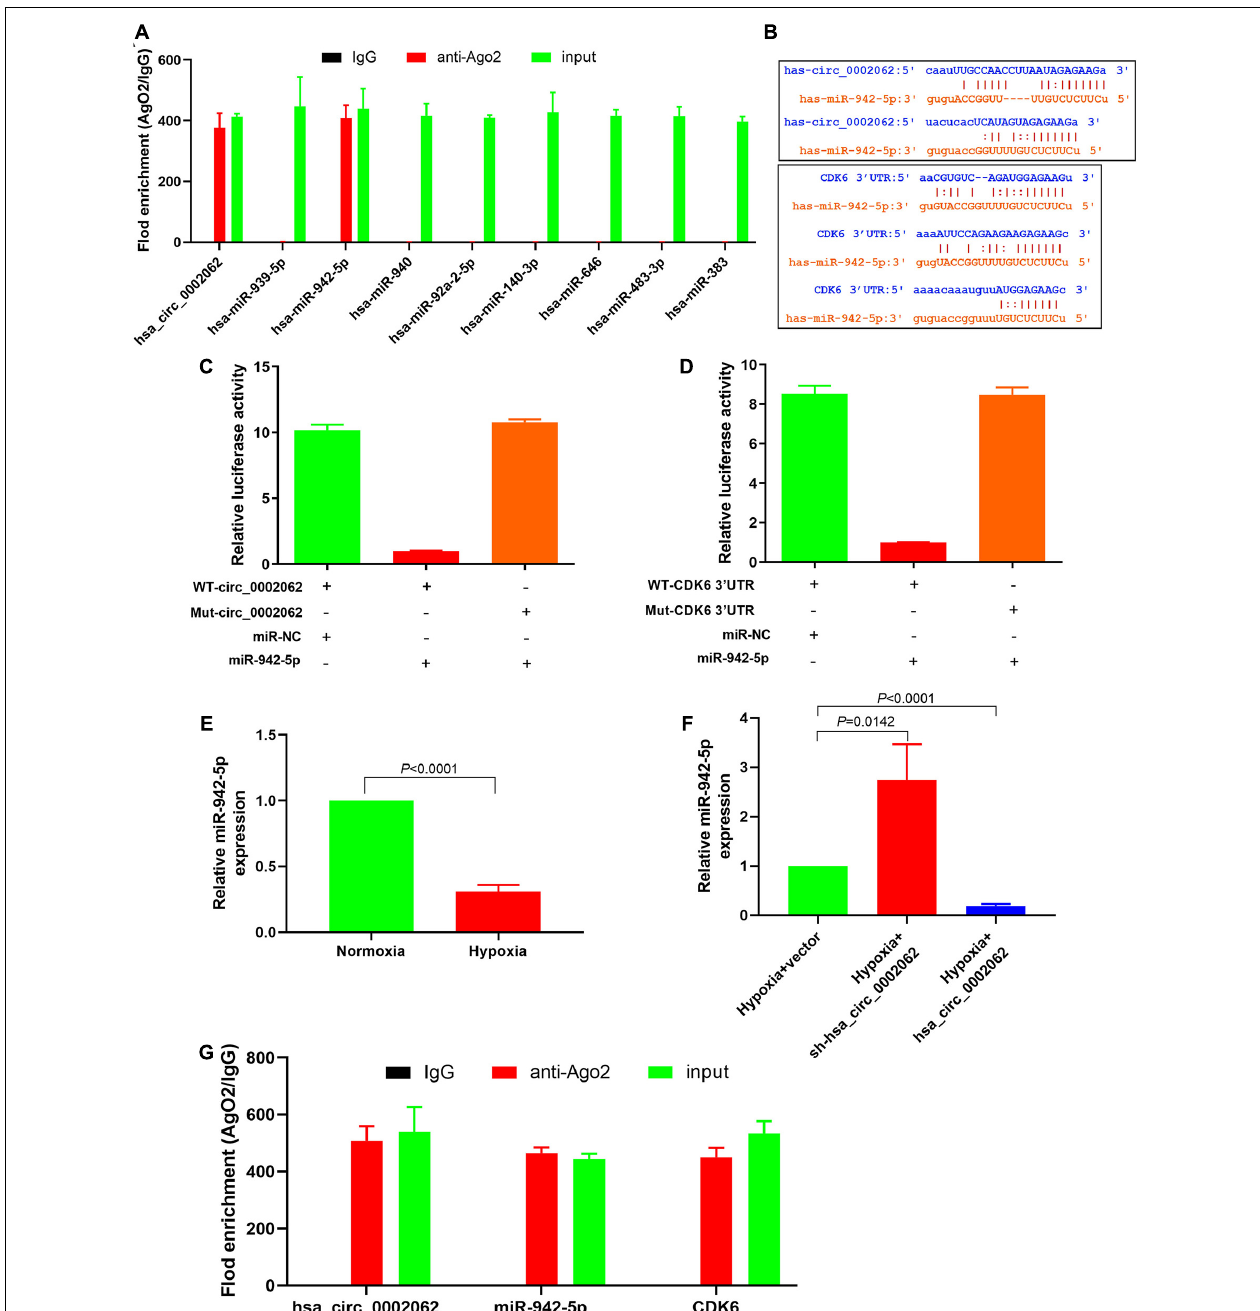
FIGURE 3 | Hsa_circ_0002062 upregulates the expression of CDK6 by competitively binding to hsa-miR-942-5p. (A) RIP showing that hsa_circ_0002062 binds to hsa-miR-942-5p as a miRNA sponge. (B) ENCORI analysis indicating the binding sites common to hsa-miR-942-5p, hsa_circ_0002062 and the CDK6 3 (cid:48) UTR region. (C,D) Luciferase reporter assay validating the direct interaction between hsa-miR-942-5p and hsa_circ_0002062 or the CDK6 3 (cid:48) UTR. (E) The expression level of hsa-miR-942-5p in hPASMCs was significantly decreased under hypoxia. (F) Knockdown of hsa_circ_0002062 elevates hsa-miR-942-5p expression in hPASMCs, while overexpression of hsa_circ_0002062 inhibits the expression of hsa-miR-942-5p. (G) RIP showing that hsa_circ_0002062, miR-942-5p, and CDK6 were enriched in Ago2-containing precipitates. Error bars represent the mean ± SD from triplicate experiments.